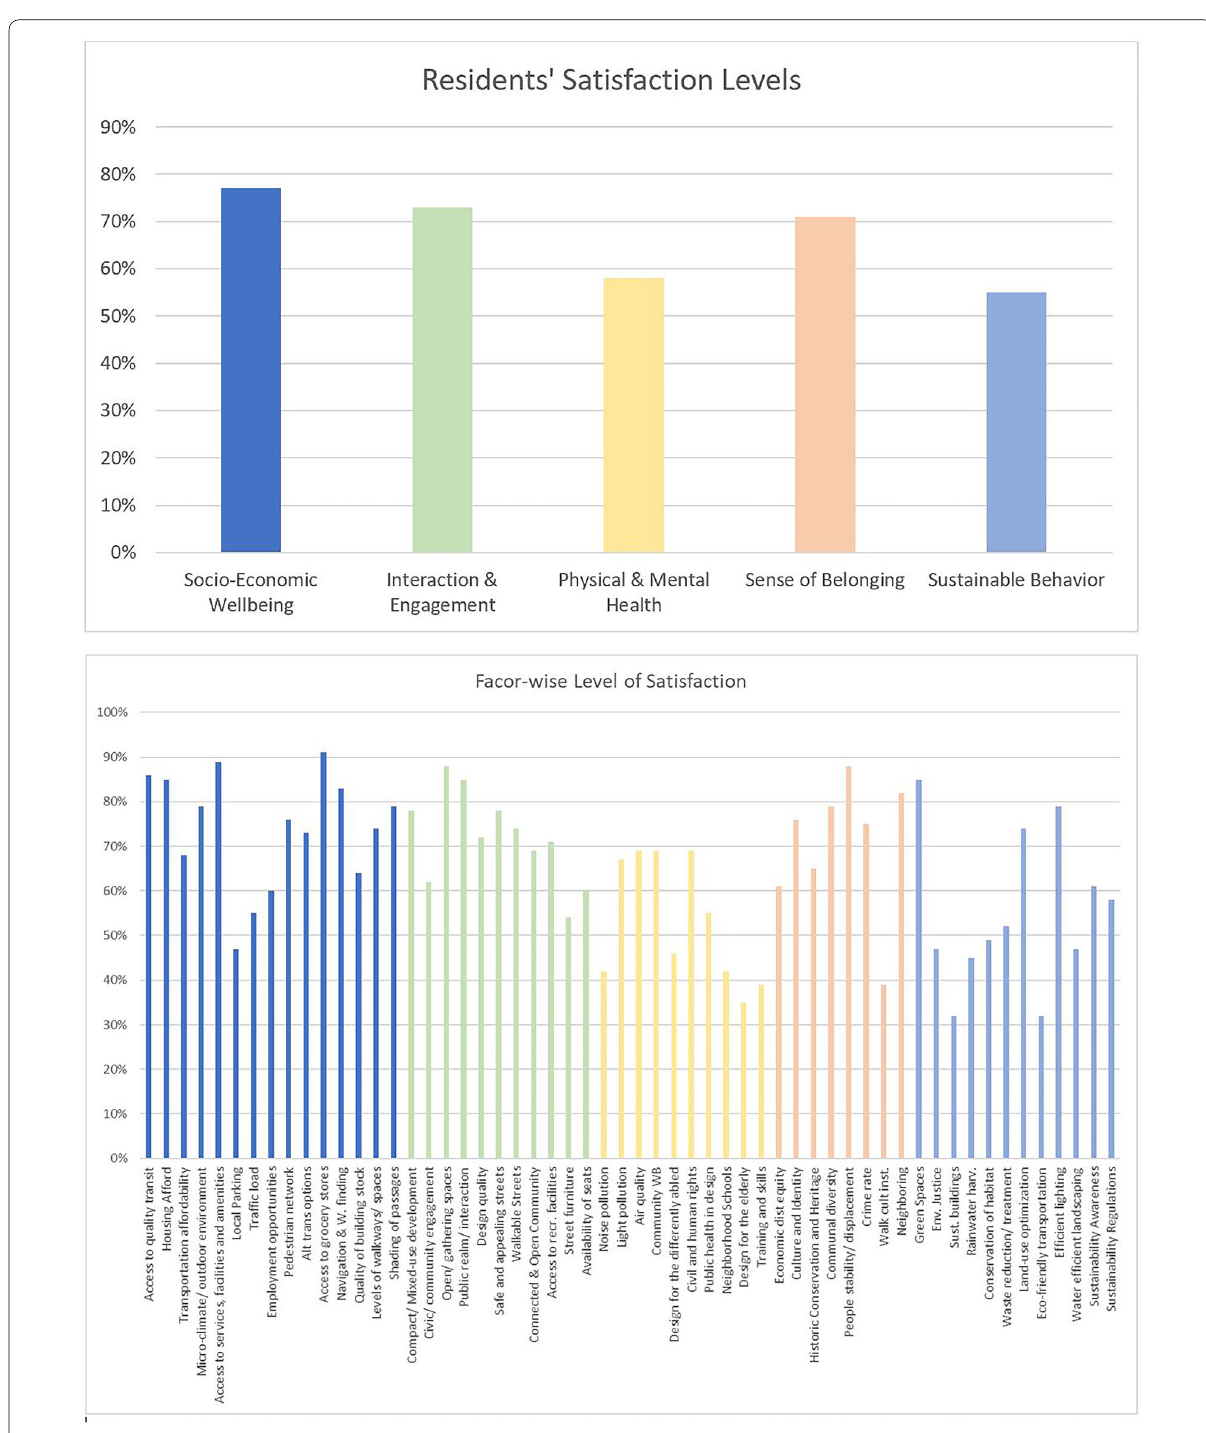
Fig. 13 Residents’ satisfaction levels by rating category (top) and by factor